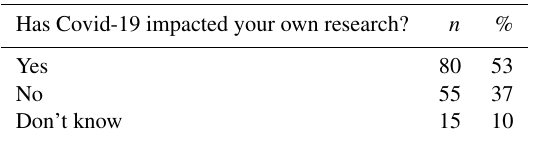
Table 2. Responses to “Has Covid-19 impacted your own research on risk perception and/or